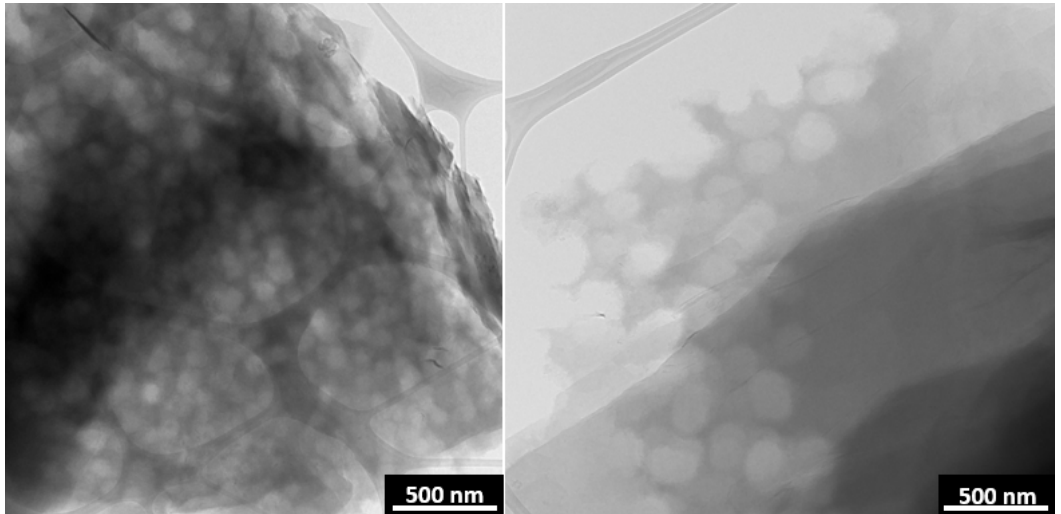
Figure 7. TEM micrographs of Swiss-Cheese-Graphite formed from CO 2 laser annealing of anthracene-fluorene coke.